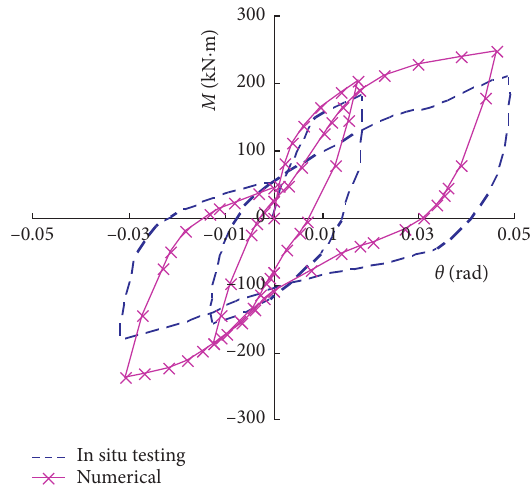
Figure 1: Relation of moment and rotation of bucket foundation in in situ tests at